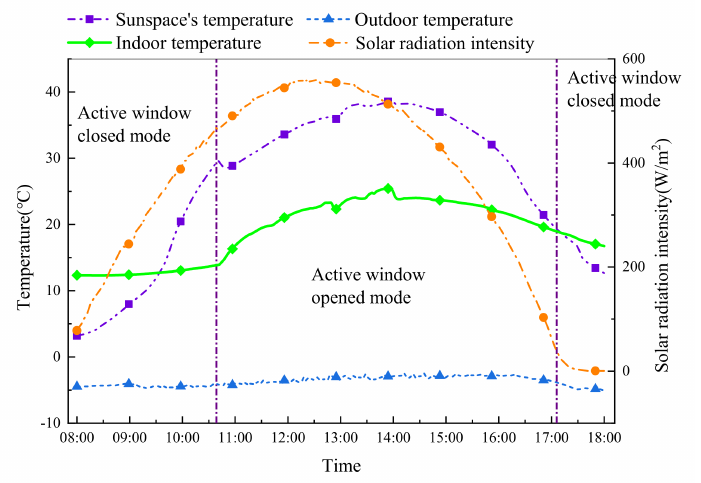
Figure 10. Temperature of room under zero-state response control strategy on 28